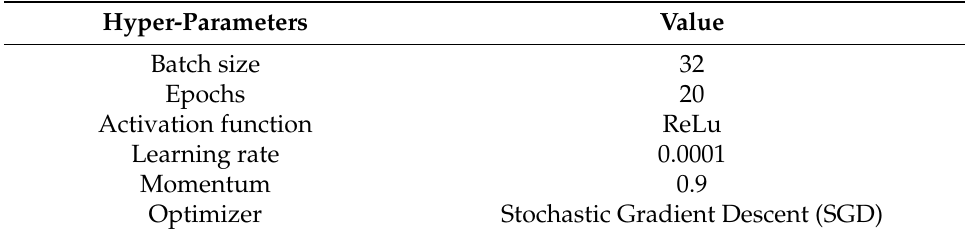
Table 5. Hyper-parameters